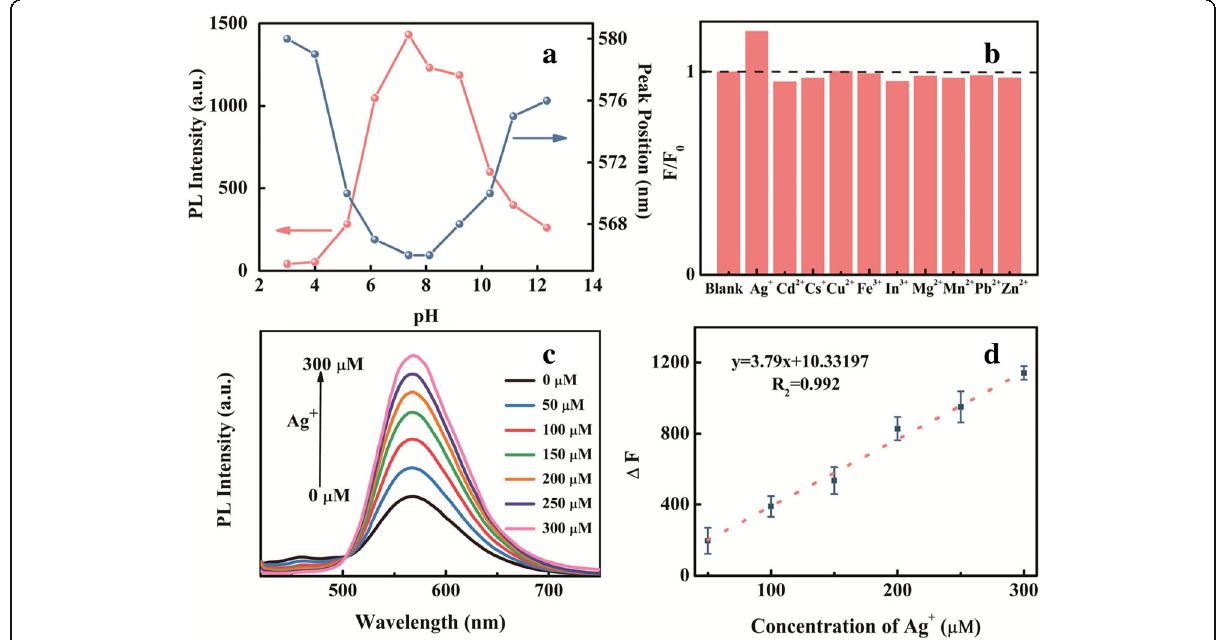
Fig. 4 a PLs intensity and peak position of NCDs in different pH values. b PL intensity ratios ( F / F 0 ) of NCDs, F 0 is the PL intensity of the original NCDs, while F is that of NCDs treated with different metal ions (50 μ M). c PL spectra of NCDs treated with the increasing titrations of Ag + from 0 to 300 μ M, λ ex = 400 nm. d Plot of fluorescent intensity of NCDs against Ag + concentration in the range of 0 to 300 μ